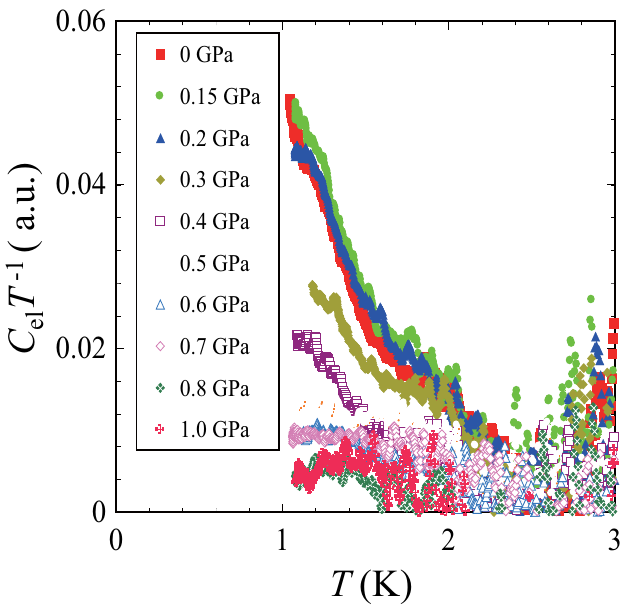
Figure 6. Pressure dependence of the heat capacity peak of (Et-4BrT)[Ni(dmit) 2 ] 2 . Pressure dependence of the heat capacity of (Et-4BrT)[Ni(dmit) 2 ] 2 obtained under pressure up to 1.0 GPa. The magnetic ordering of localized π-electrons on dimers is suppressed by pressure and gradually changes to the metallic ground state with the increase of external